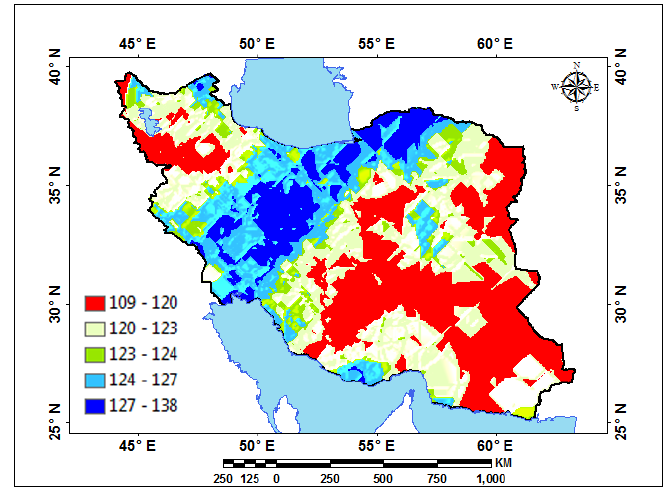
Figure 11. Forecast of winter rainfall variations (seasonal additive model).